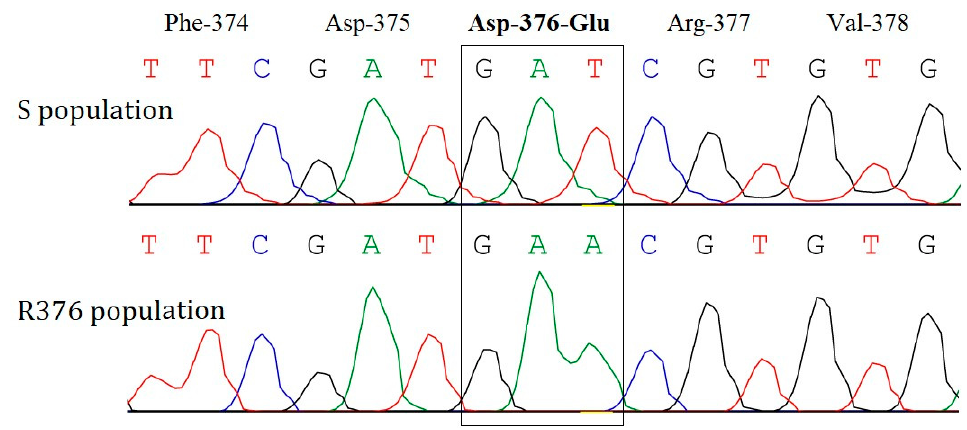
Figure 1. Comparison of acetolactate synthase ( ALS ) gene partial sequences from S and R376 popula- tions of Setaria viridis . Table 1. Values of GR 50 to nicosulfuron for S and R376 S. viridis populations with and without